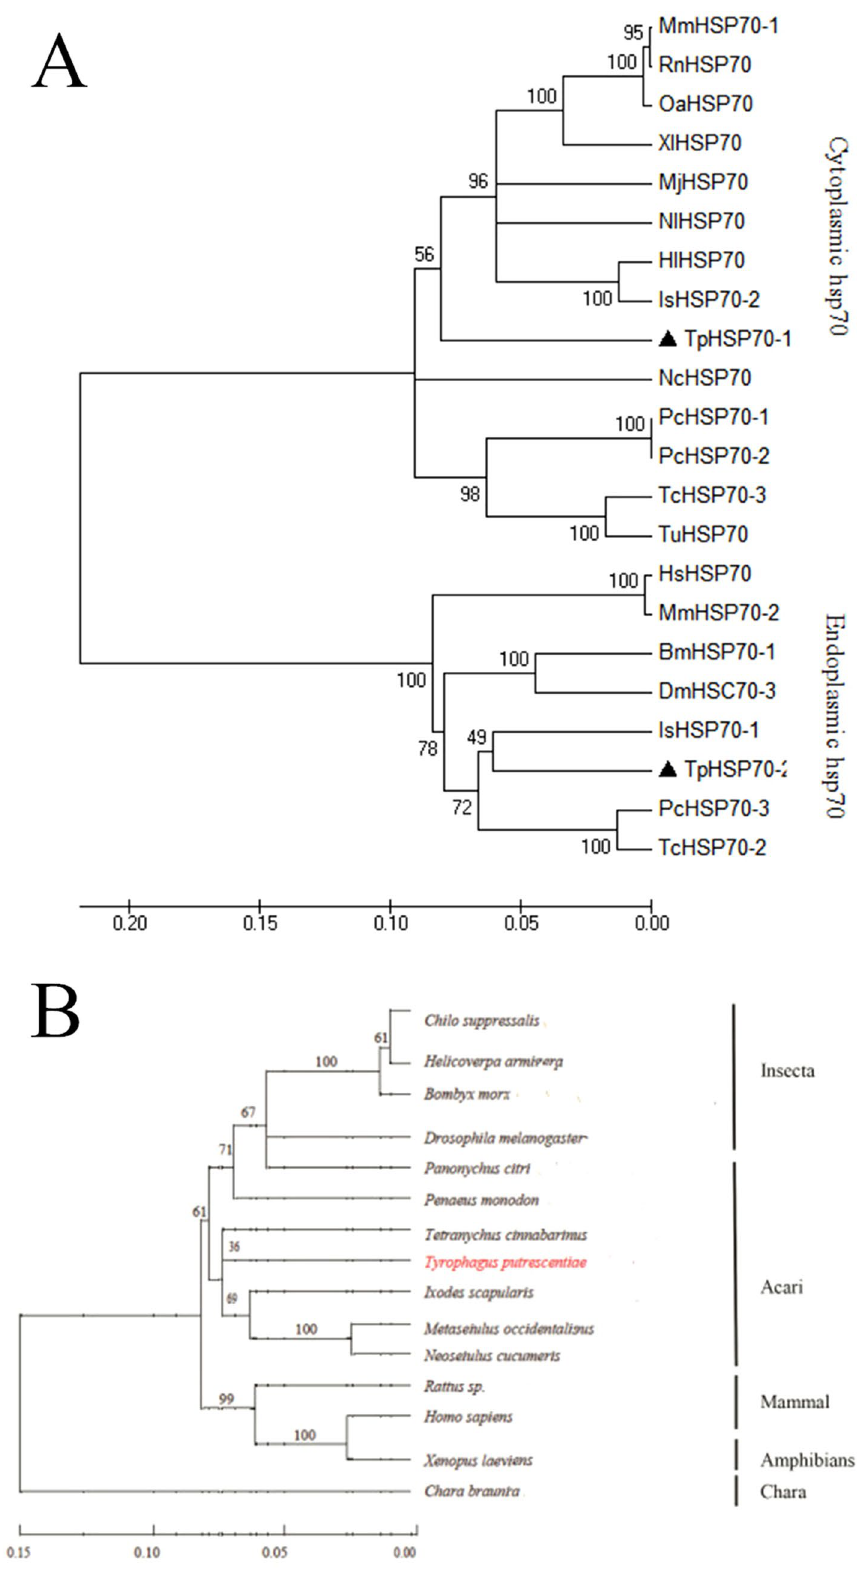
Figure 3. Phylogenetic tree of HSP70 ( A ) and HSP90 ( B ) from T. putrescentiae and other species. Constructed by the neighbor joining method based on amino acid sequences. Numbers at each branch indicate the percentage of times, and a node is supported in 1,000 bootstraps pseudo-replication by neighbor